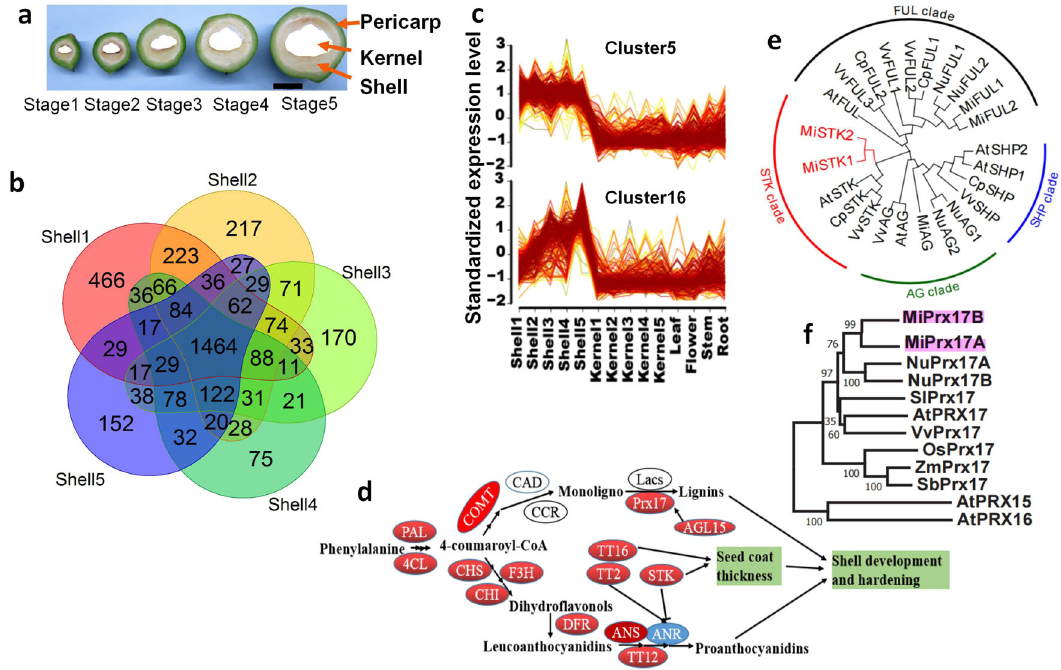
Fig. 3 Shell development in M. integrifolia . a Phenotype of shell and kernel at different stages of fruit development. b Venn plot of up expression genes in stage Stage 1, Stage 2, Stage 3, Stage 4, and Stage 5 of shells. c Mfuzz clustering of differentially expressed transcripts in shell, kernel, and other tissues. d Schematic of shell development and hardening. A proposed model of STK , TT16, and Prx17 in regulation of shell development and hardening. e Phylogenetic tree of STK , AG , FUL, and SHP genes in multiple species, including M. integrifolia , N. nucifera , A. thaliana , V. vinifera, and C. papaya . STK , AG , FUL, and SHP clades are indicated in different colors. f Phylogenetic tree of Prx17 in M. integrifolia , N. nucifera , A. thaliana , V. vinifera , S. lycopersicum , Z. mays L., O. sativa , and S. bicolor